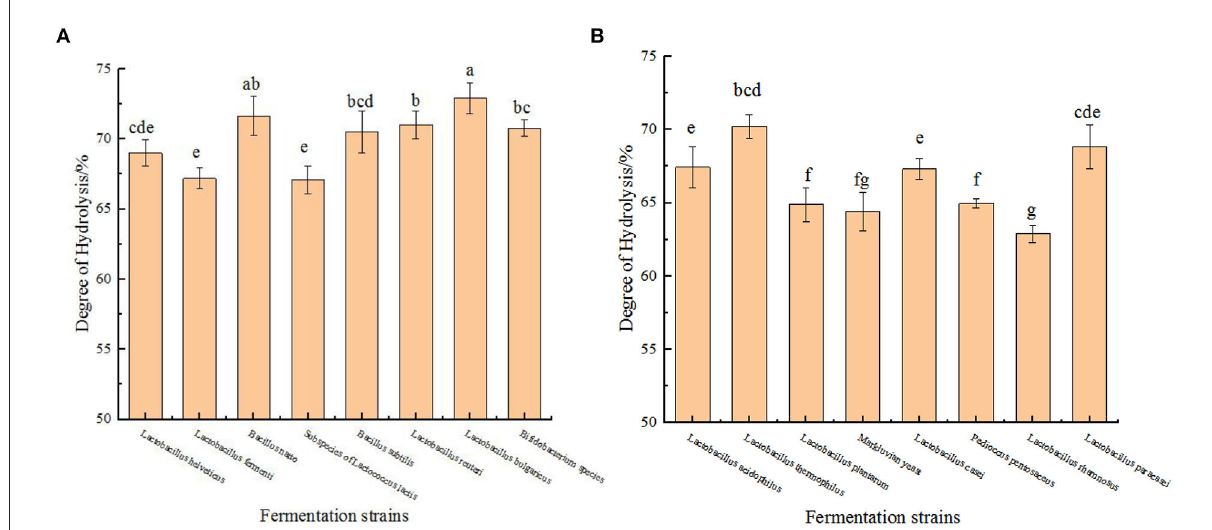
FIGURE2 Detection results of the protein content in the fermentation residue. (A) Hydrolysis degree produced by fermentation of chickpea by 8 strains ( Lactobacillus helveticus, Lactobacillus fermenti, Bacillus natto, Subspecies of Lactococcus lactis, Bacillus subtilis, Lactobacillus reuteri, Lactobacillus bulgaricus, Bifidobacterium species) at their respective optimal fermentation time. (B) Hydrolysis degree produced by fermentation of chickpea by 8 strains ( Lactobacillus acidophilus, Lactobacillus thermophilus, Lactobacillus plantarum, Markluvian yeast, Lactobacillus casei, Pedioccus pentosaceus, Lactobacillus rhamnosus, Lactobacillus paracasei ) at their respective optimal fermentation time. The values are presented as the mean of three replicates ± standard deviation. Different letters indicates the significant differences among samples ( p -value ≤